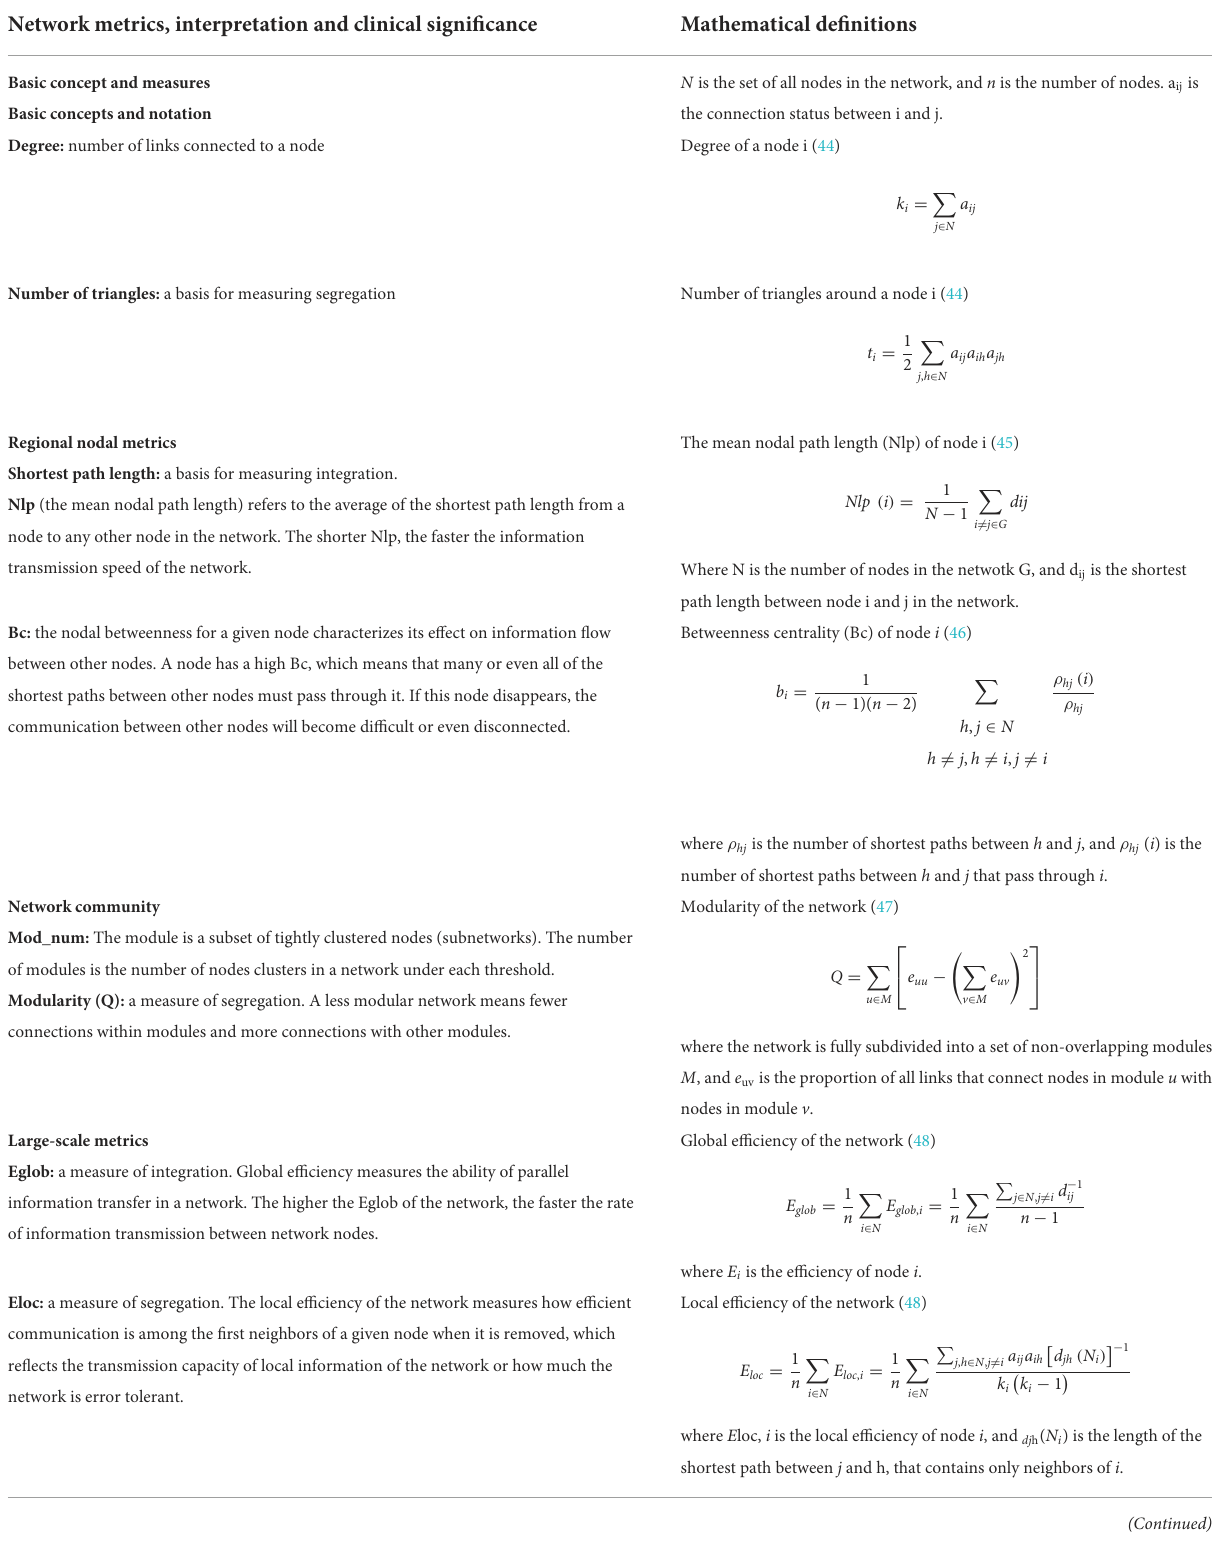
TABLE 3 Mathematical definitions, interpretation, and clinical significance of the network metrics